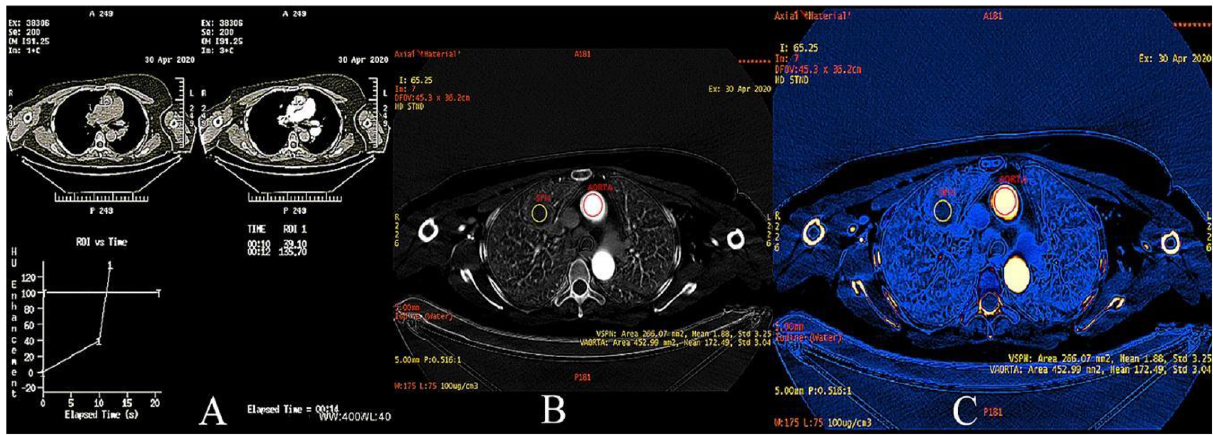
Figure 3. Exceeding the density of 100 HU in the ROI in the ascending aorta initiates the DECT ( A ) scan . Presentation of iodine concentrations at the reference site on the Linear Gray map ( B ) scan and the Color map ( C ) scan. DECT (ascending aorta—red ROI) and in the lung tumor (SPN—yellow ROI). Iodine concentration in the aorta and lung focal lesion is 172.49 × 100 µg/cm 3 and 1.88 × 100 µg/cm 3 , respectively. DECT dual-energy computed tomography, SPN solitary pulmonary nodule, ROI region of